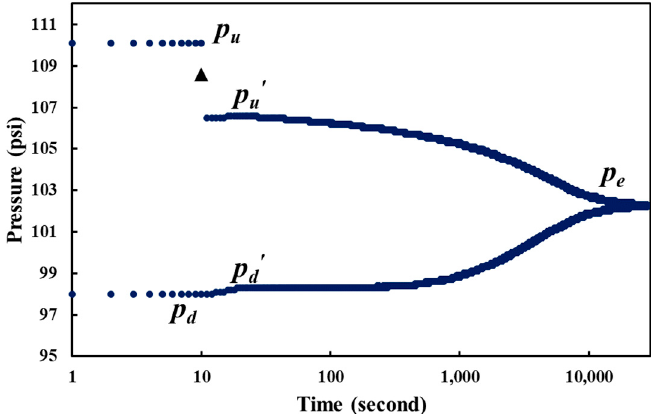
Figure 3. Pressure data points in estimating total porosity and secondary accessible porosity in a pulse-decay experiment.